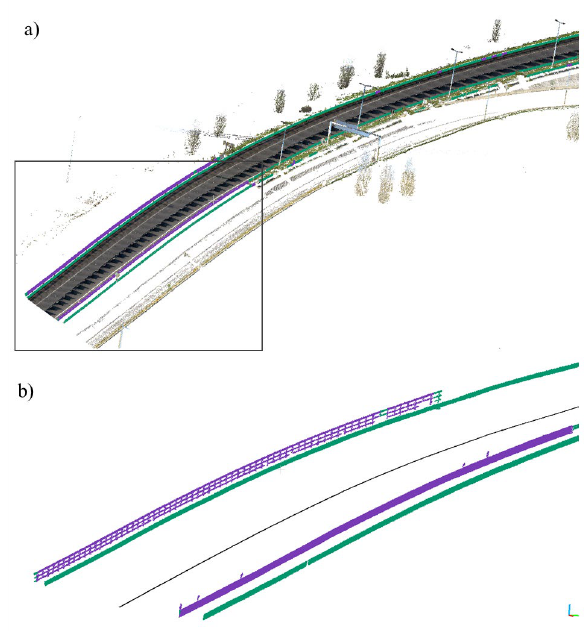
Figure 8. A partial view of results obtained for case study e (concrete barriers in violet, and guardrails in